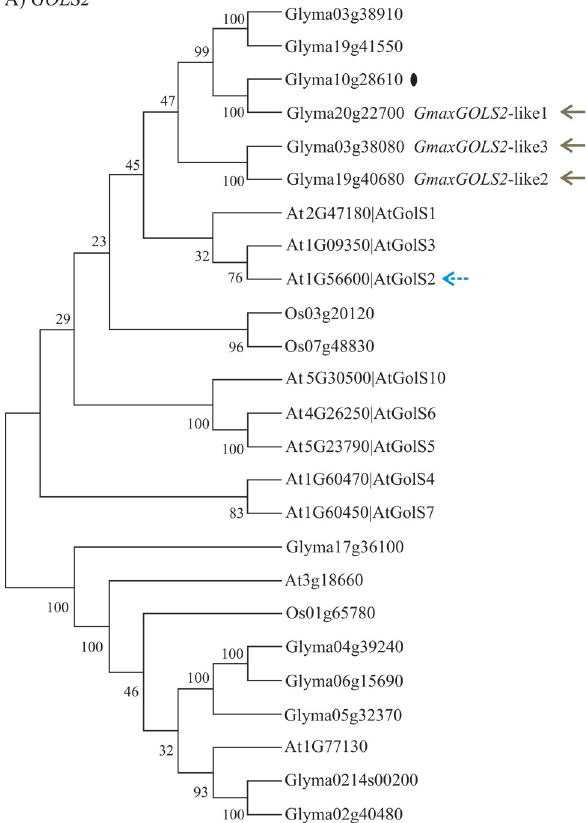
Figure 4 - Dendrogram of the GOLS gene using a gene model based on amino acid sequences for drought of responsive genes in Arabidopsis thaliana , Oryza sativa and Glycine max, . The green solid arrow indicates soybean candidates, while the blue dotted arrow point to Arabidopsis ref- erence gene, and the black dot indicates another GmGOLS candidate gene. Bootstrap values (1,000 replications) are indicated at the base of each